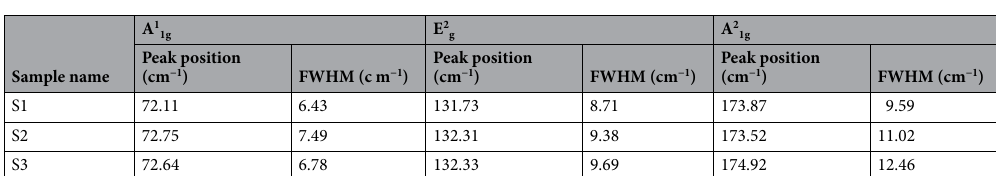
Table 1. Room temperature Raman data for Bi 2 Se 3 thin films on sapphire (0001)